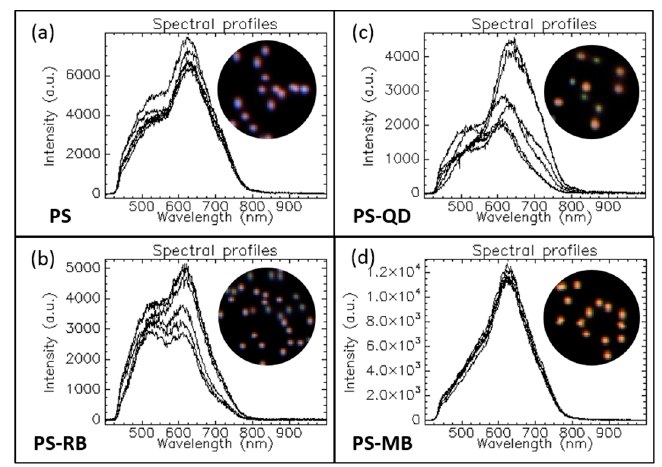
Figure 3. Six spectral profiles showing optical differences among randomly selected PS NPs encapsulating different cargos. The insets correspond to dark field images of the NPs. ( a ) Bare PS NPs; ( b ) PS loaded with rhodamine (RB); ( c ) PS loaded with quantum dots (QD); ( d ) PS loaded with methylene blue (MB). The results were obtained using a CytoViva ® with an Olympus UPlan FLN 60X 1.25 N.A. oil objective, a tungsten–halogen lamp as the illumination source, and a Pixelfly hyperspectral camera based on pushbroom line scanning.